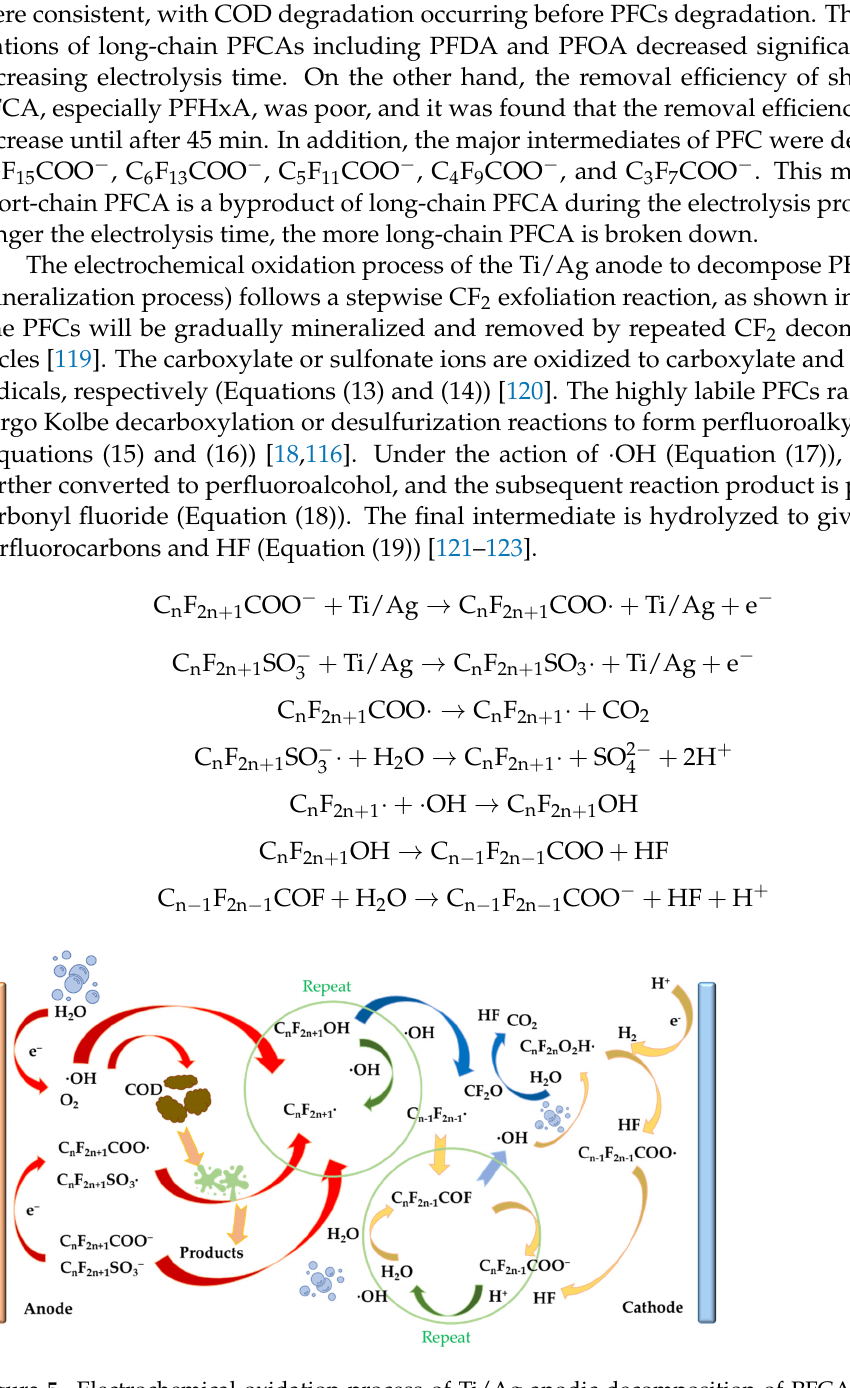
Figure 5. Electrochemical oxidation process of Ti/Ag anodic decomposition of PFCA (stepwise ex- foliation of CF 2 ) Reprinted/adapted with permission from Ref. [119] . 2021, c Tang, J.; Liu, Z.; Lu, W.; Wang, L.; Zhang, C.; Su,